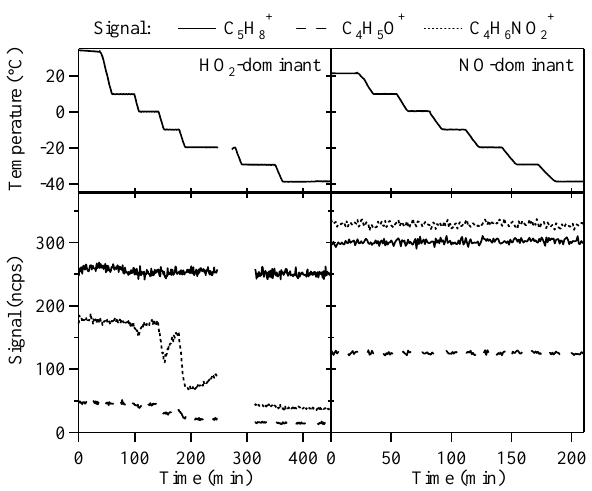
Fig. 6. Time series of (top) trap temperature and (bottom) signal intensities of C 5 H 8 + ( m/z 69.0654), C 4 H 5 O + ( m/z 69.0335), and C 4 H 6 NO 2 + ions ( m/z 100.0393). These ions nominally represent ISOP, MACR, and MVK, respectively, when using the NO + reagent ion (cf. Fig. S8 for H 3 O + ). Results are shown both for HO 2 - and NO-dominant conditions (Experiments #1 and